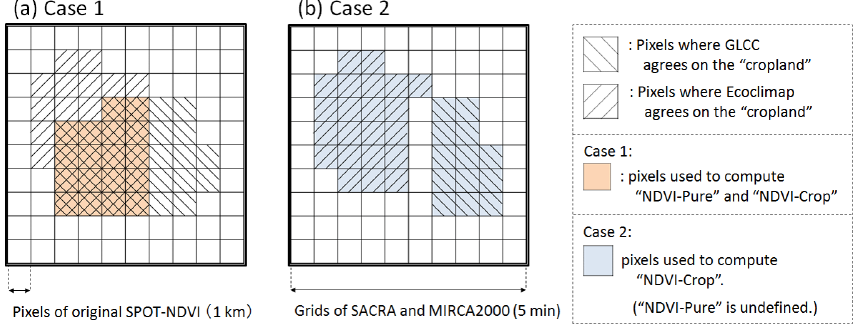
Figure 4. Schematic image of the aggregation of NDVI-Pure and NDVI-Crop from the 1km resolution original NDVI. Small-sized squares with thin lines represent pixels of the original SPOT-NDVI (1km resolution). Large-sized squares with bold lines represent grids of SACRA and MIRCA2000 (5arcmin resolution). Pixels with diagonal lines (from upper left to bottom right and from bottom left to upper right) show where GLCC and Ecoclimap agree on the cropland.